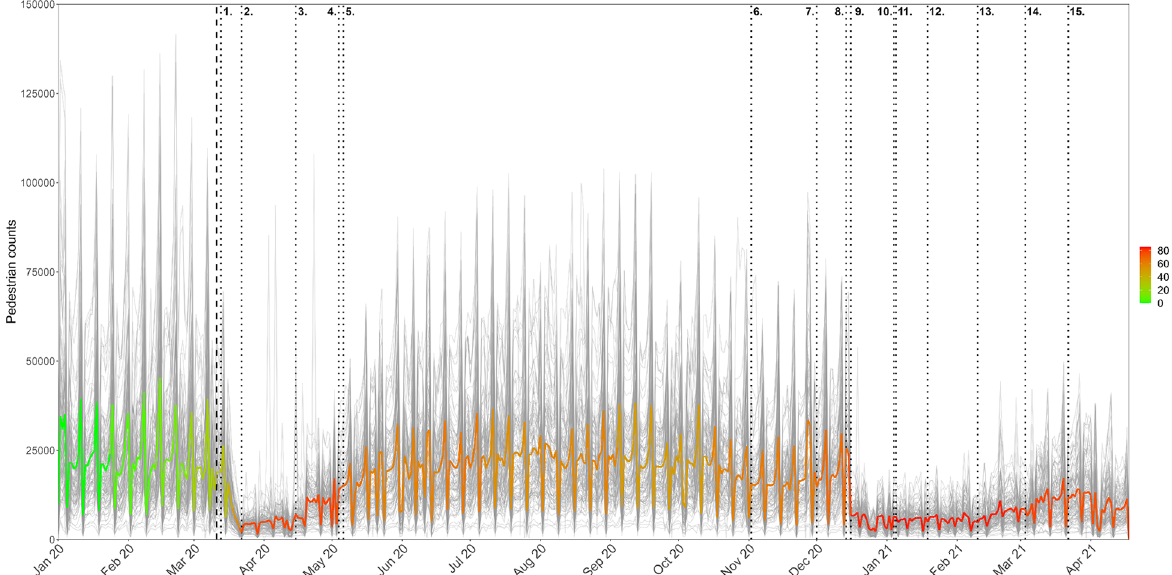
Figure 2: Pedestrian counts in 49 German cities at 100 locations between 01.01.2020 and 18.04.2021